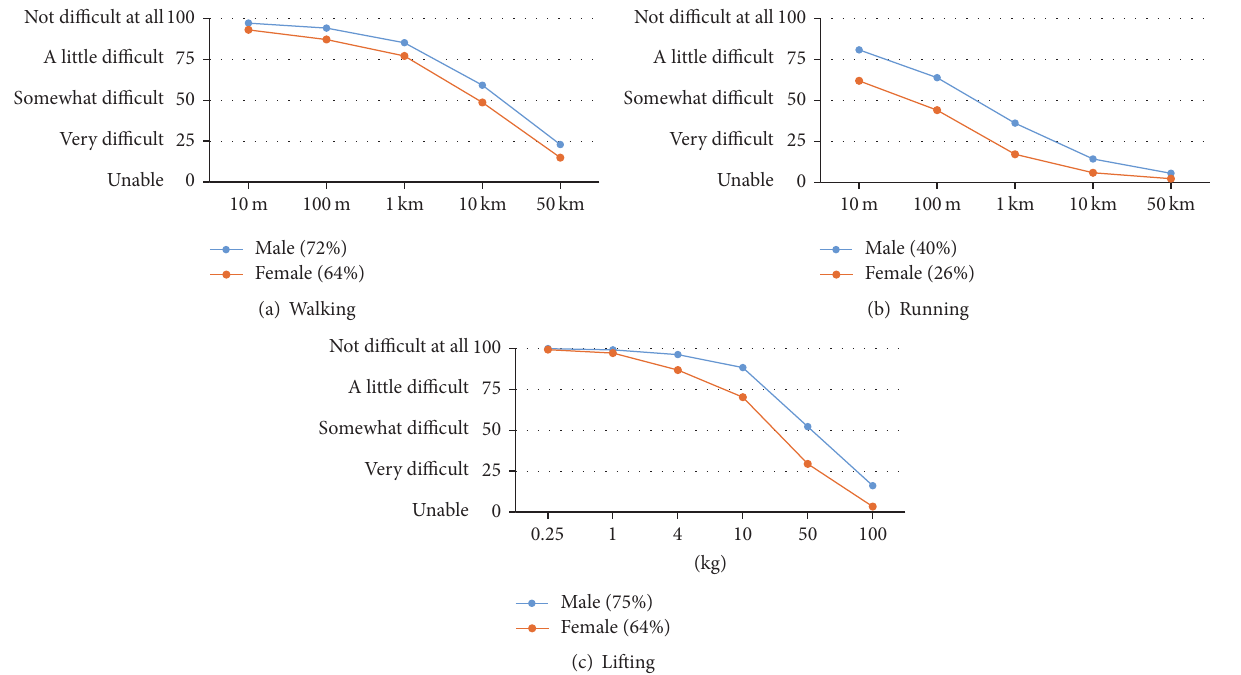
Figure 2: Mean walking, running, and lifting ability curves and summary scores for men and women.